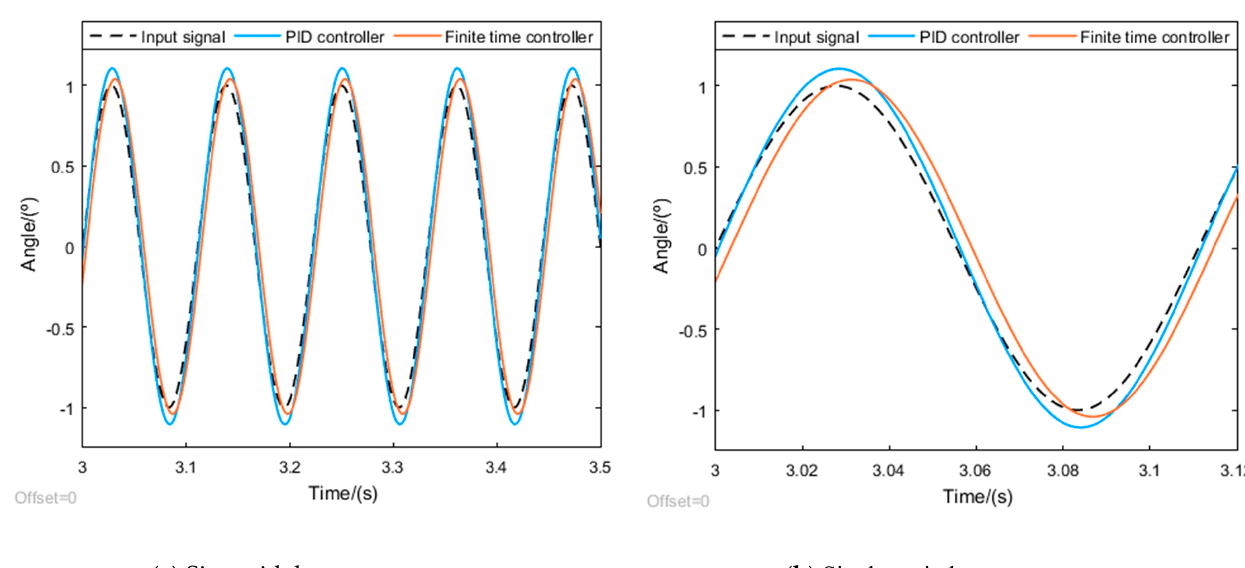
Figure 7. Finite-time composite control response curve of the motor system with 8 Hz and 1°sinus- oidal signal.